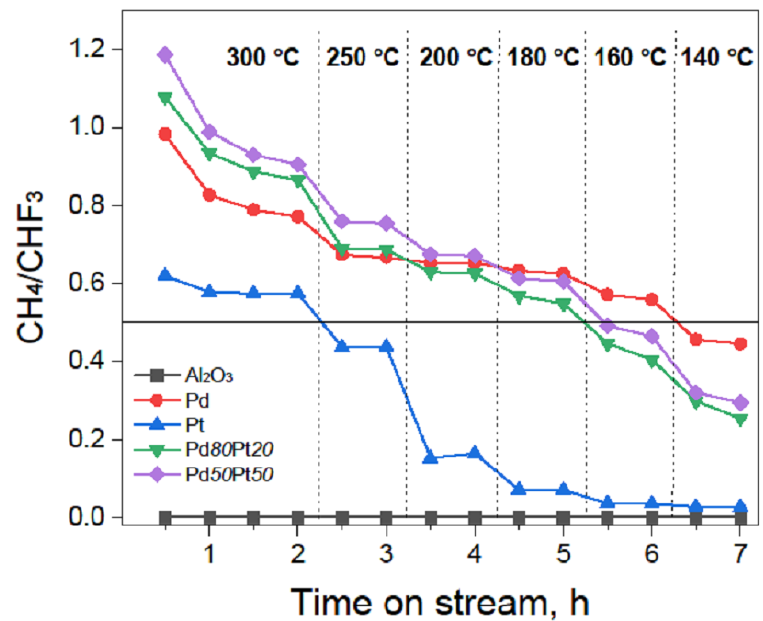
Figure 2. Effect of reaction temperature on the CH 4 /CHF 3 product ratio in the hydrodechlorination of freon R-22 (CHClF 2 ) over alumina, Pd/Al 2 O 3 , Pt/Al 2 O 3 and two Pd-Pt/Al 2 O 3 catalysts. Note that the CH 4 /CHF 3 product ratio ≥ 0.5 (resulting from total hydrogenolysis of CHCl 3 , marked by black solid line) would be an indication of full dechlorination of R-22. Operating conditions as in Figure 1. Table 2. Hydrodechlorination of freon R-22 (CHClF 2 ) over alumina-supported metal catalysts: extents of conversion and product selectivities at the reaction temperature 180 °C. Data obtained in preliminary kinetic runs. Operating conditions: CHClF 2 /H 2 /Ar = 1:8:39, GHSV = 14,400 Ncc/hg cat , P ≈ 1 bar. Product Selectivity,